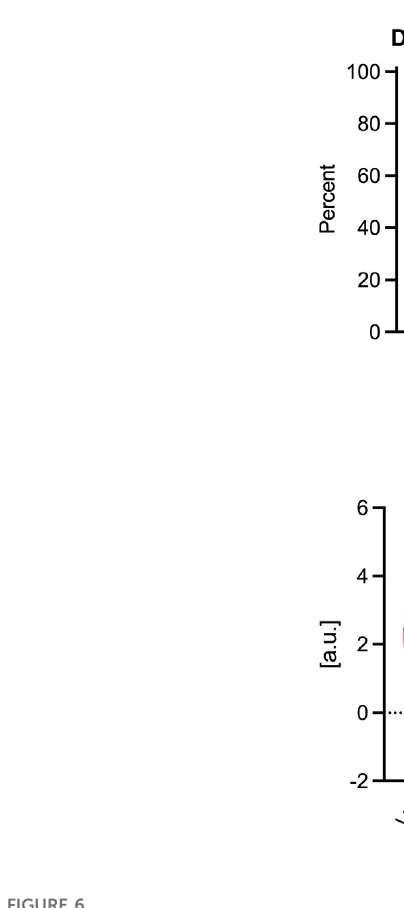
Frontiers in Virtual